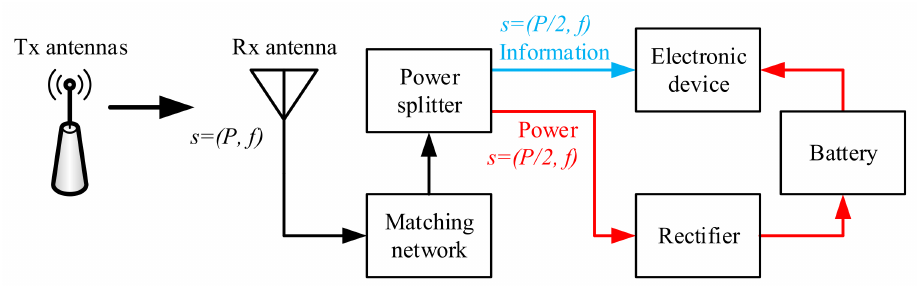
Figure 1. Typical SWIPT implementation for a single